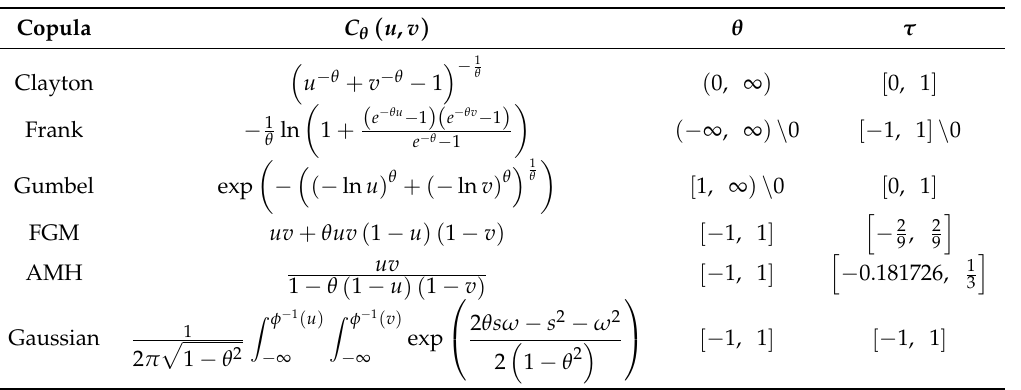
Table A1. Copulas tested in this study including the definition and the ranges of the copula parameter θ and the corresponding rank correlation coefficient τ